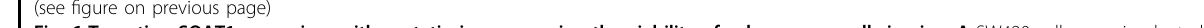
Fig. 6 Targeting SOAT1 synergizes with nystatin in suppressing the viability of colon cancer cells in vivo. A SW480 cells were implanted subcutaneously in nude mice, and randomly divided into 4 groups ( N = 6). Each group was intraperitoneal injection with control solvent (normal saline, PEG300, and DMSO), avasimibe (15 mg/kg.d), nystatin (4 mg/kg.d) and combined drugs. After 4 weeks, the xenografts were measured and weighed. The bar graphs indicate tumor volume and weight of each group. B Representative pictures of YAP staining in xenograft tumor tissues. The graph indicates the IHC scores of YAP expression. Scale bar: 20 μ m. C Mouse models of AOM/DSS-induced colorectal cancer were described in ‘ Materials and methods ’ section. The mice were randomly divided into 4 groups ( N = 5), each group was intraperitoneally injected with control solvent, avasimibe (15 mg/kg.d), nystatin (4 mg/kg.d) and combined drugs during the period of drinking normal water. The graphs showed the average number and tumor area of each group. Statistical methods: one-way ANOVA followed by Tukey post hoc test, * p < 0.05, ** p < 0.01, *** p < 0.001, NS indicates no signi fi cant difference. D The model of regulation of YAP by cholesterol in colon cancer. LRP6 is released from the cholesterol- rich membranes (lipid rafts) and directly binds to FZD7, resulting in the inactivation of PCP-YAP pathway and classical Wnt pathway when lack of cholesterol. After membrane cholesterol levels increased, LRP6 is transfered to cholesterol-rich area, alleviating the inhibitory effect of LRP6 on PCP- YAP pathway, and activating classical Wnt pathway